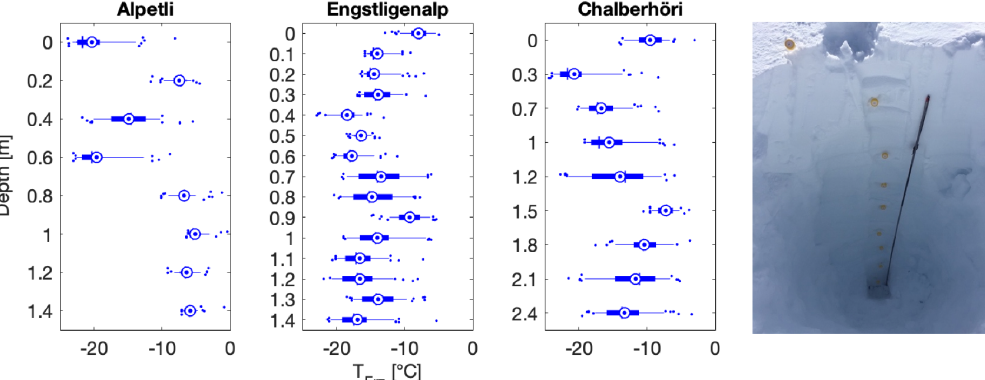
Figure 10. Depth profiles of snowmelt freezing temperatures at three different sampling sites, namely at Alpetli on 17 March 2018, at Engstligenalp on 14 April 2018 and at Chalberhöri on 2 April 2018 (Table 1). Right inset: a 2.7m deep snow profile was dug with an aluminum avalanche rescue shovel at the sampling site Engstligenalp. The probe depicted is an avalanche rescue probe and was used to measure the snow depth. The fresh layer snow was 9d old and the first snowfall at that site was recorded on 23 November 2017. In the boxplots, the blue concentric dot is the mean, the blue horizontal line is the median, the box is the 25th to the 75th percentiles, and the whiskers extend from the 5th to the 95th